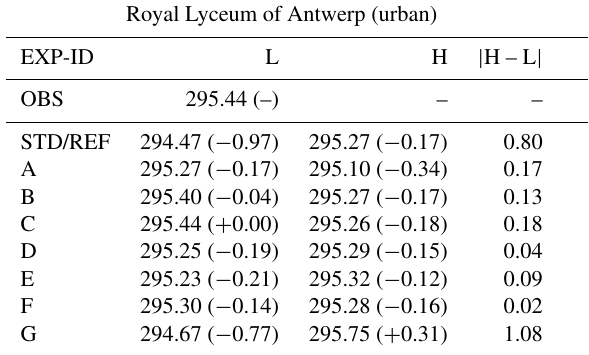
Table 5. Idem Table 3, but averaged values for the day (between 06:00 and